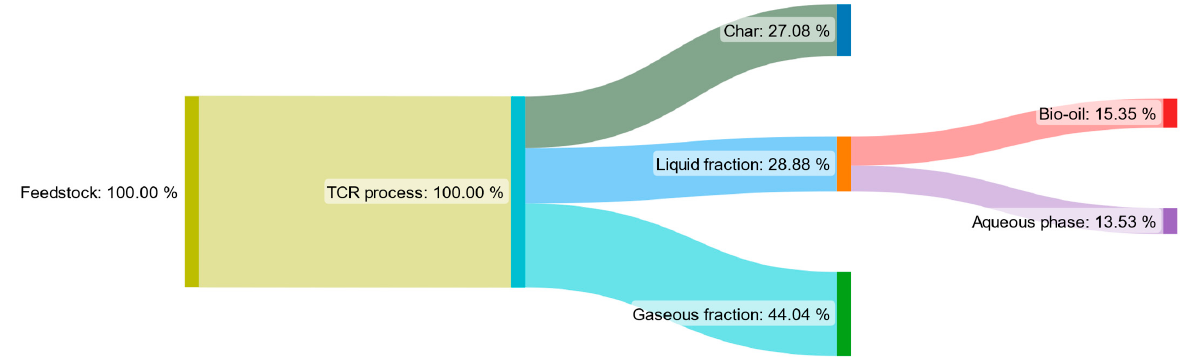
Figure 2. Sankey diagram for average biomass-based feedstock applied to the TCR process (based on literature data—see reference in Table 1).